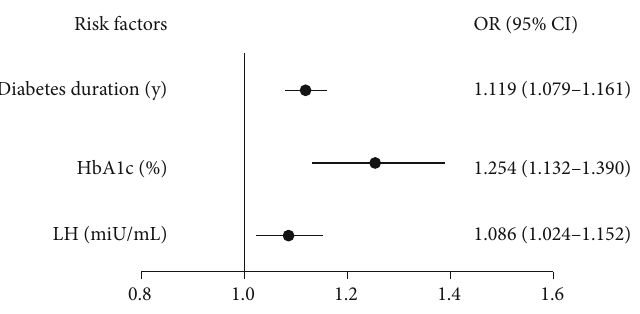
Figure. 1: Independent risk factors for male diabetic retinopathy patients. Binary logistic regression analysis was performed by adjusting for age, smoking, drinking, systolic BP, BMI, HbA1c, TG, TC, FSH, T, DHEAS, and SHBG. Table 2: Characteristics of male subjects by the severity of diabetic